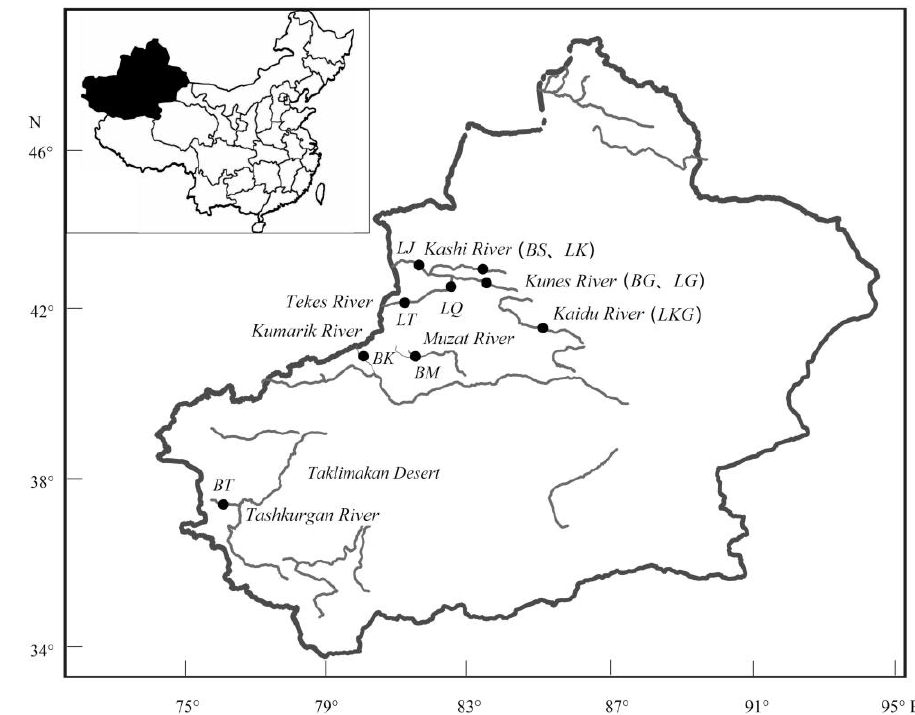
Figure 1. Sampling map of two Scizothoracins corresponding to Table 1.